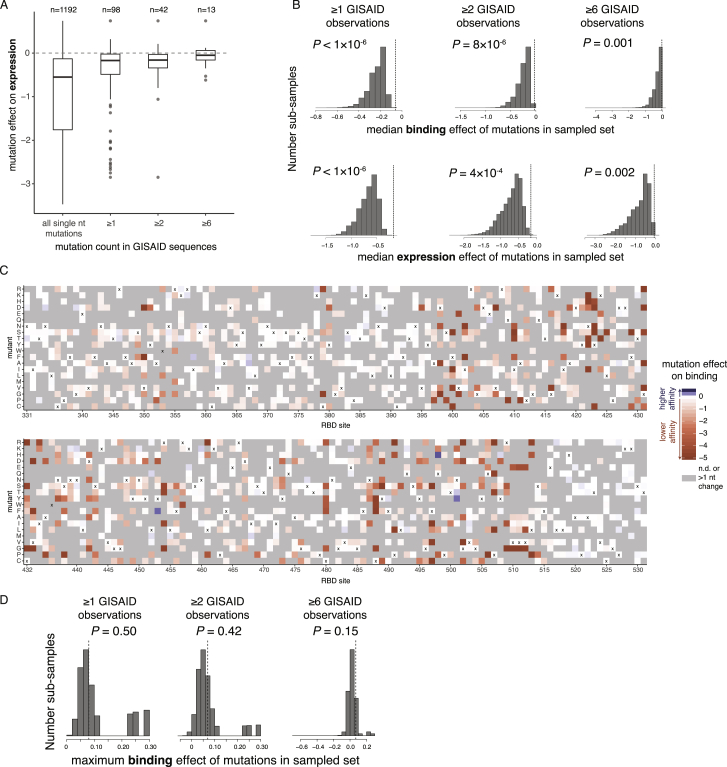
Genetic Variation and Selection in SARS-CoV-2, Related to Figure 7(A) Distribution of expression effects of mutations observed among circulating SARS-CoV-2 isolates. Details as in Figure 7A. (B) Permutation tests indicating the action of purifying selection on binding (top) and expression (bottom) among circulating SARS-CoV-2 mutations. For each threshold of GISAID observation counts, 1 million random sub-samples of single-nucleotide-accessible amino acid changes were generated at the same sample size as the true mutation set (n = 98, 42, and 13 for the ≥ 1, ≥ 2, and ≥ 6 thresholds). A P-value was determined as the fraction of sub-samples with median mutational effect on binding or expression equal to or greater than that of the actual GISAID mutation set (dashed vertical line). The observation that the set of mutations observed in GISAID have a more favorable median mutational effect on binding and expression than randomly sampled mutations indicates the action of purifying selection for ACE2 binding and RBD stability. (C) Heatmaps depicting effects of mutations on ACE2 binding, indicating only those mutations that are accessible via single-nucleotide mutation from the SARS-CoV-2 Wuhan-Hu-1 isolate gene sequence. Amino acid mutations that require more than one nucleotide change are in gray. (D) Permutation tests for positive selection for enhanced ACE2 affinity. Random sub-samples were generated as in (B), and the maximum affinity-enhancing effect of mutations in each sub-sample was compared to that in the actual GISAID mutation set. A P-value was determined as the fraction of sub-samples with a maximum effect on binding equal to or greater than in the actual GISAID mutation set (vertical dashed line). We do not see evidence for selection for enhanced ACE2 binding, as randomly sampled mutations generally contain mutations with stronger affinity-enhancing effects than observed in the GISAID mutation set.